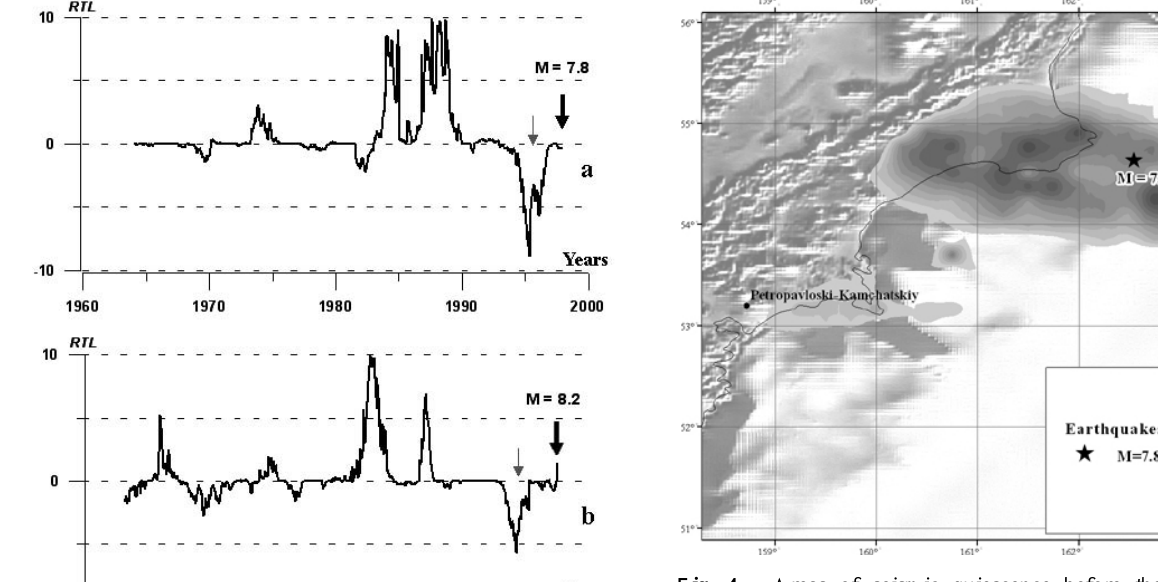
Fig. 4. Areas of seismic quiescence before the Kronotskoe earthquake. The star marks the main shock M = 7 . 8.